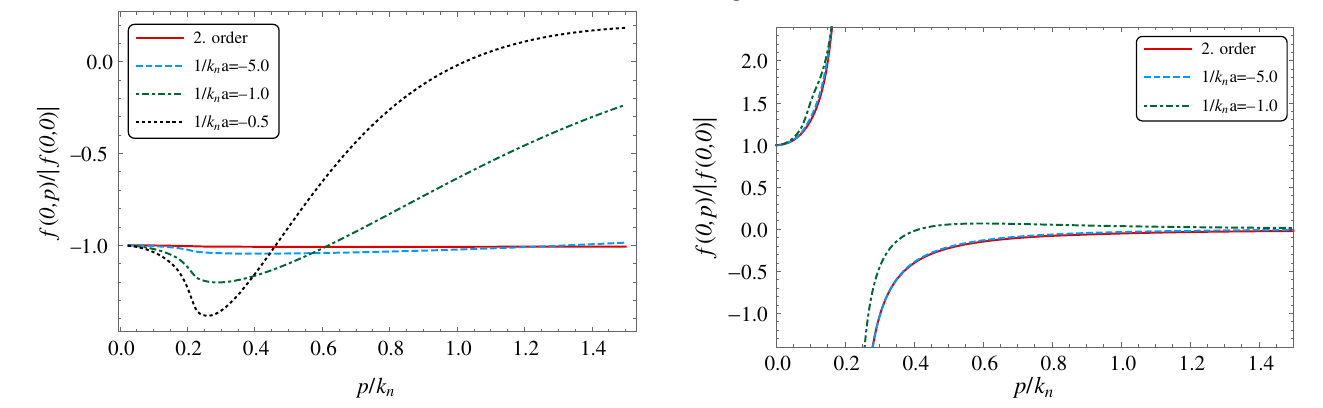
FIG. 5. The Landau effective interaction f ð 0 ; p Þ for m=m 40 = 87 , vanishing impurity concentration, T ¼ 0 , k and various impurity-boson scattering lengths. The second-order perturbative results are also